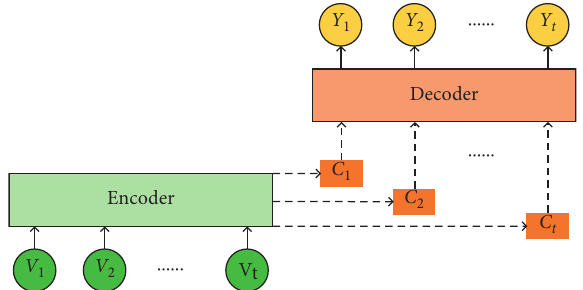
Figure 8: Schematic diagram of the attention